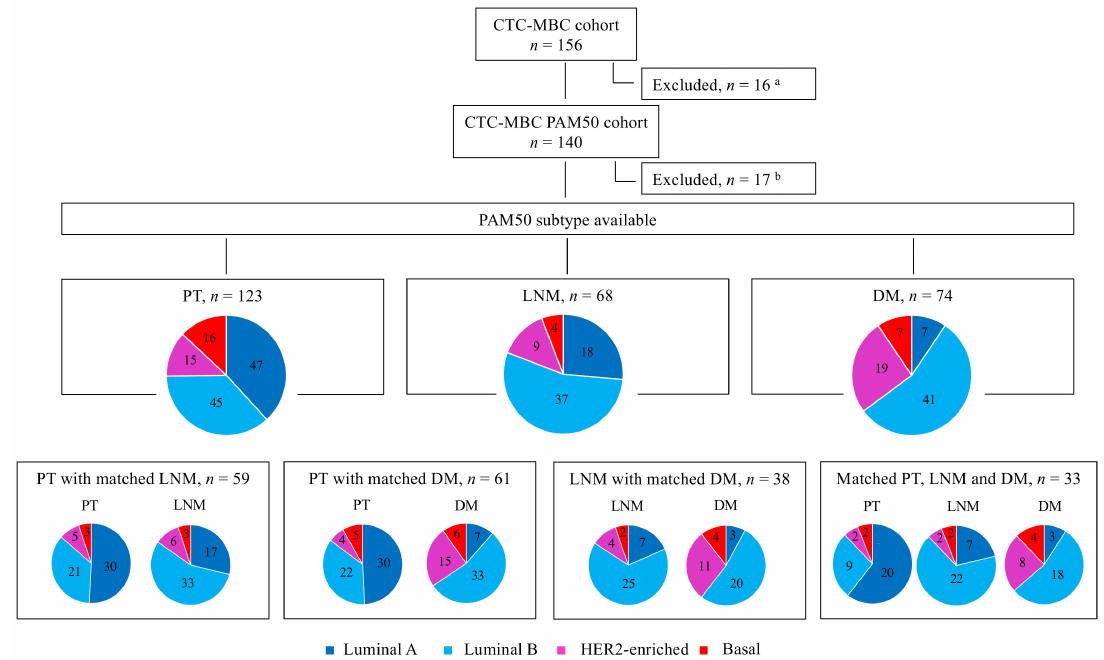
Figure 1. Flow chart of the study population and PAM50 breast cancer intrinsic subtype distribution between tumor sites. a Patients were excluded from the study population due to any of the following reasons: sample being unavailable, no tumor tissue in the available sample, only locoregional sample available, or unsuccessful RNA extraction. b Patients were excluded due to unsuccessful NanoString Breast Cancer 360 (BC360) assay or because PAM50 subtypes could not be assigned. Abbreviations: CTC: circulating tumor cell; DM: distant metastasis; HER2: human epidermal growth factor receptor 2; LNM: lymph node metastasis; MBC: metastatic breast cancer; PT: primary